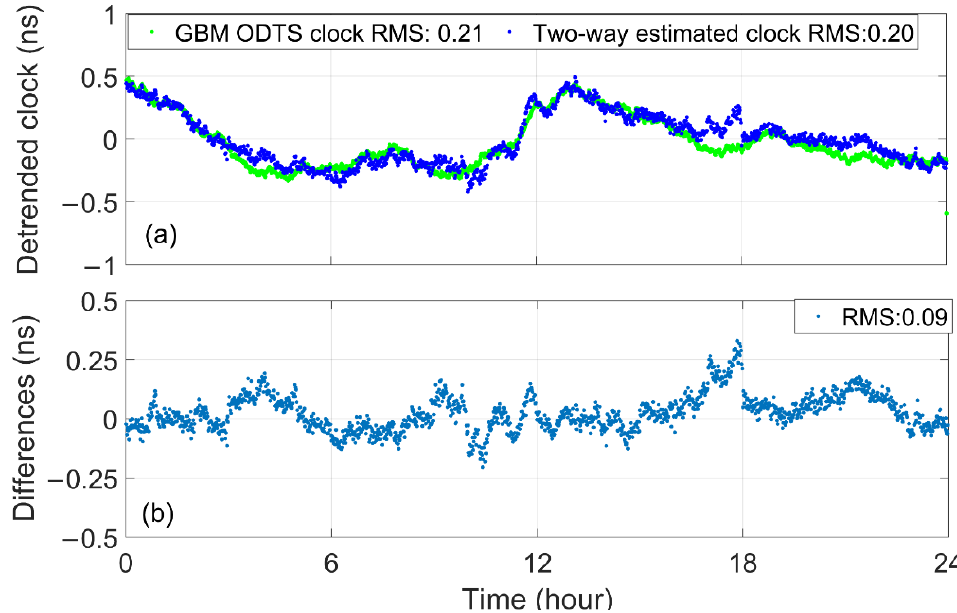
Figure 9. 1-day Satellite clock offset differences between the Ka-band inter-satellite estimated clock offsets and GBM products (since 19 May 2022). Wherein, ( a ) describes the two kinds of clock offsets after deducting the same trend. ( b ) describes their differences.